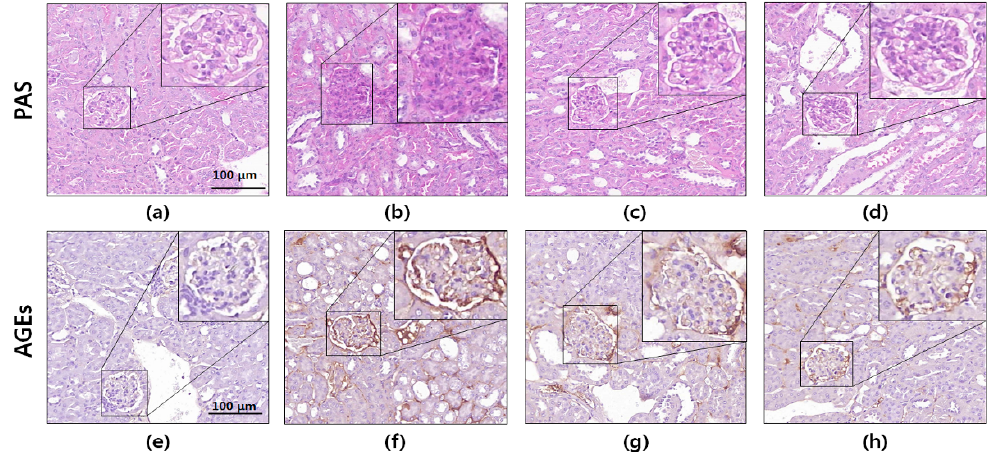
Figure 5. Periodic acid–Schiff (PAS) and immunohistochemical (IHC) staining of db/db mice kidney tissues. Photomicrographs of ( a – d ) PAS staining and ( e – h ) IHC staining of advanced glycation end products. The images shown are representative of ( a , e ) normal mice, ( b , f ) db/db control mice, ( c , g ) metformin-treated db/db mice, and ( d , h ) Spatholobus suberectus extract-treated db/db mice. Microscopic images of PAS and IHC staining are presented at 400 ×